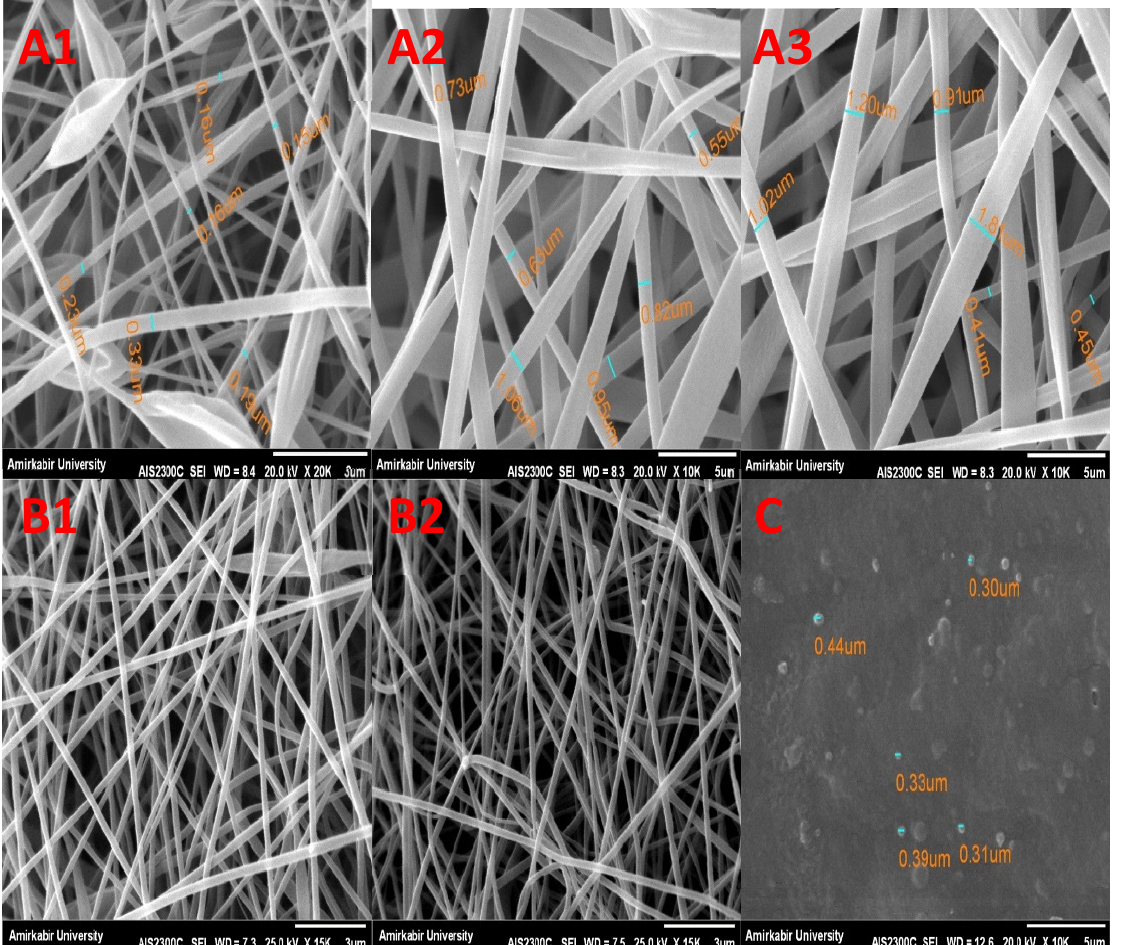
Figure 1. SEM images of SF-CS-Ag-CUR nanofibers at different CS concentration of ( A1 ) 5% w / v , ( A2 ) 7% w / v , and ( A3 ) 9% w / v . SEM images of optimized SF-CS-Ag-CUR nanofibers before ( B1 ) and- after crosslinking ( B2 ) (CS-based nanofiber crosslinked with GA vapor, and SF nanofibers crosslinked with ethanol vapor). ( C ) SEM image of reduced Ag nanoparticles in CS solution.